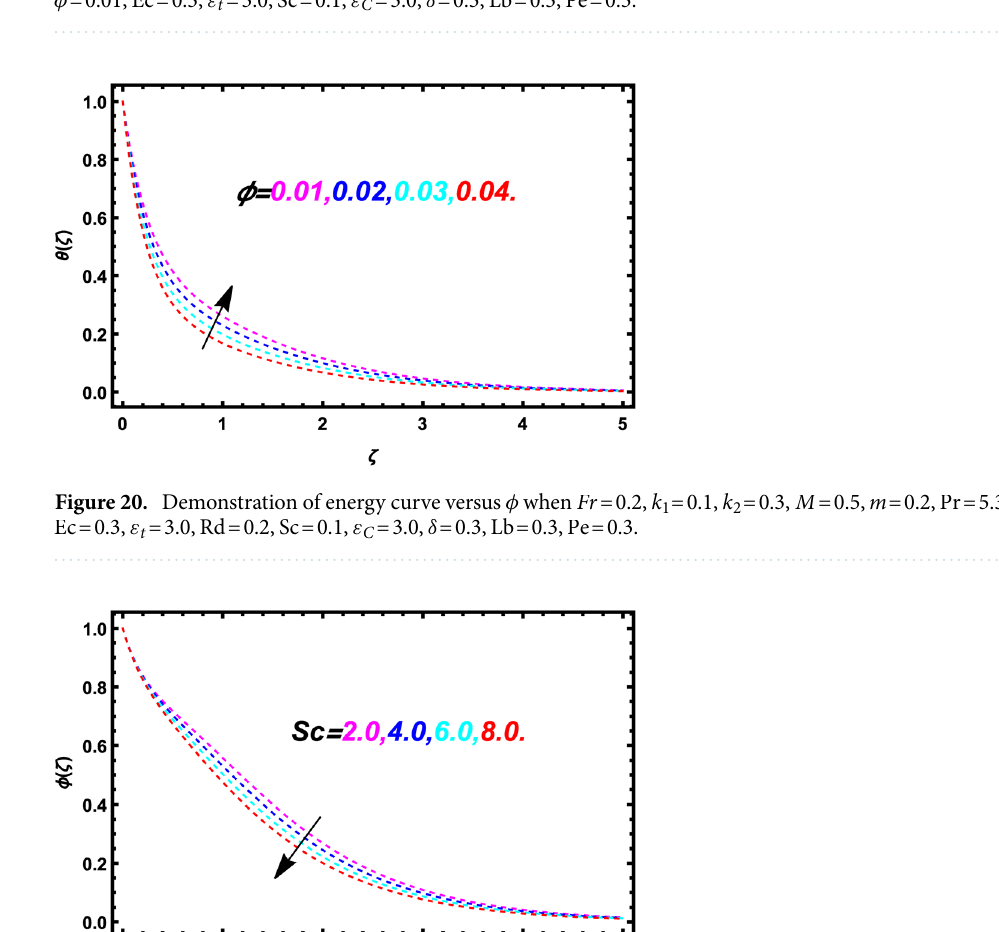
Figure 19. Demonstration of energy curve versus Rd when Fr = 0.2, k 1 = 0.1, k 2 = 0.3, M = 0.5, m = 0.2, Pr = 5.3, φ = 0.01, Ec = 0.3, ε t = 3.0, Sc = 0.1, ε C = 3.0, δ = 0.3, Lb = 0.3, Pe = 0.3.